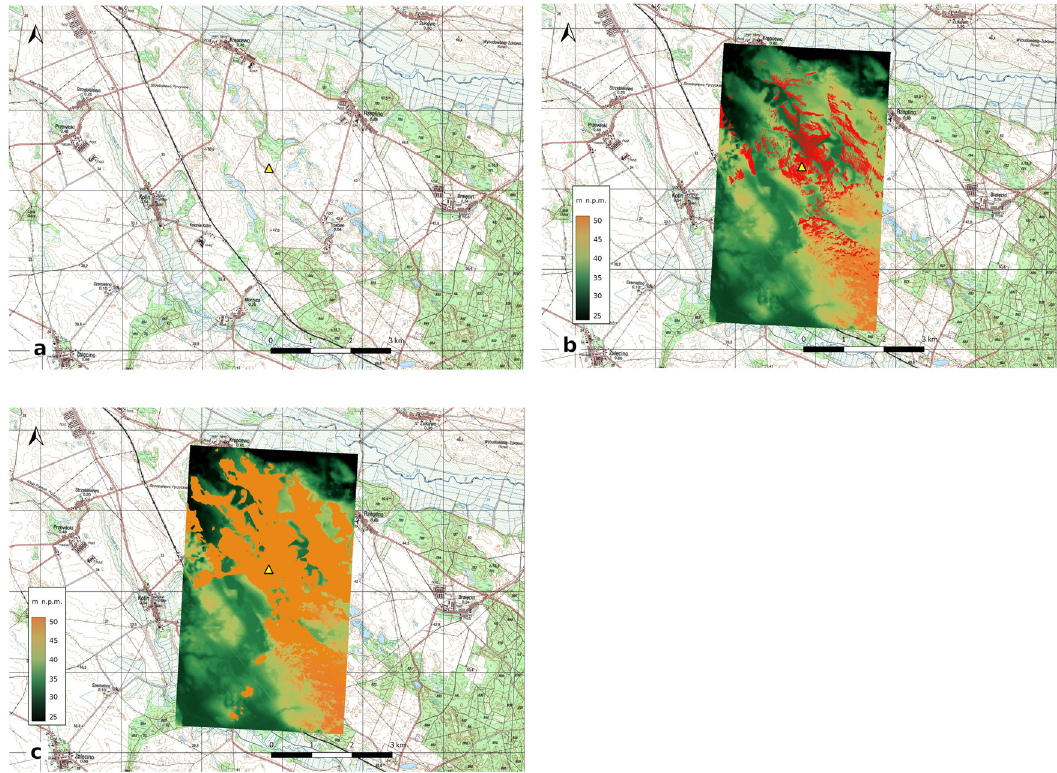
Figure 4: Megalithic tomb at Kr ę pcewo. Location of the structure ( a ) , the area visible from the tomb ( b ) and the area from which the tomb is visible ( c ) ( M. Schiller )